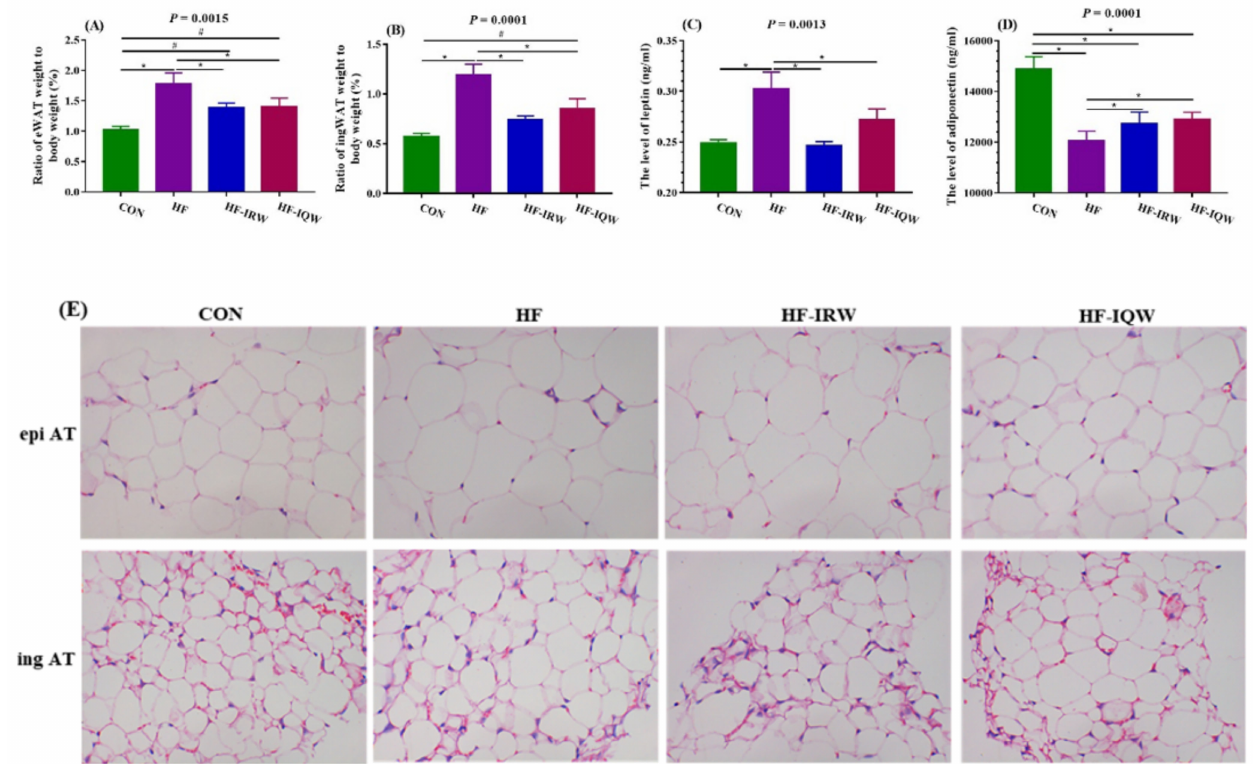
Figure 4. Effects of egg protein transferrin-derived peptides IRW (lle-Arg-Trp) and IQW (lle-Gln-Trp) on the lipid deposition of adipose tissue of mice fed an HF diet. ( A , B ) Index of ingWAT and eWAT, respectively. ( C , D ) Leptin and adiponectin levels. ( E ) ingWAT: inguinal white adipose tissue; eWAT: epididymal white adipose tissue (microscope’s magnification= 200 times). * indicates p < 0.05 between the HF group and other groups. # indicates p < 0.05 between the CON group and other